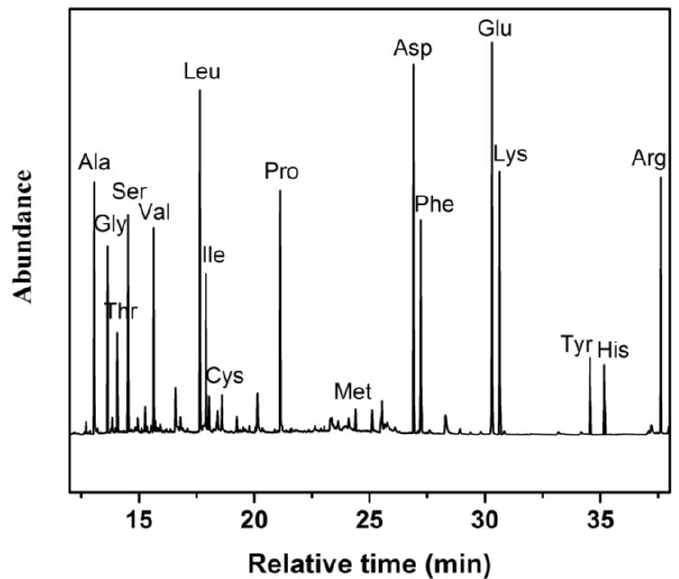
Figure 4. SEM images of aLGN nanocomposites.